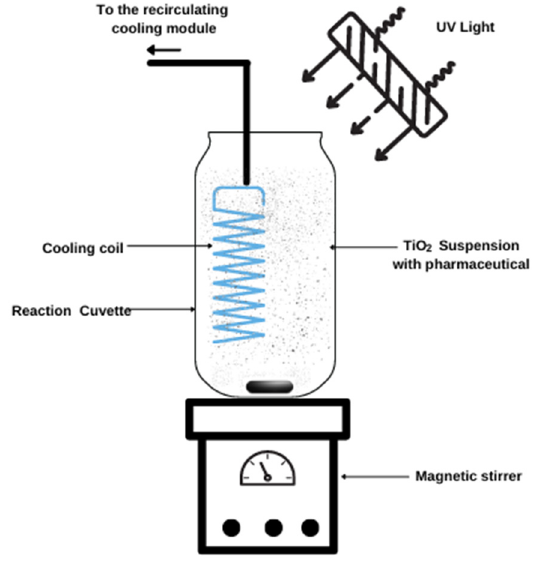
Figure 5. Photocatalytic module for the degradation of pharmaceutical dissolved in greywater.